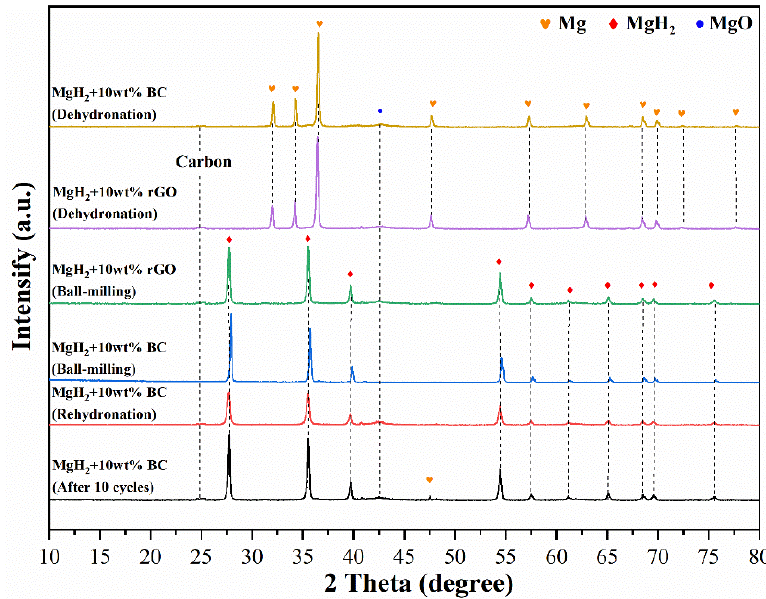
Figure 6. XRD patterns after ball milling and hydrogen dehydrogenation for MgH 2 + 10 wt% BC and MgH 2 + 10 wt% rGO. XRD pattern of MgH 2 + 10 wt% BC after rehydrogenation and 10